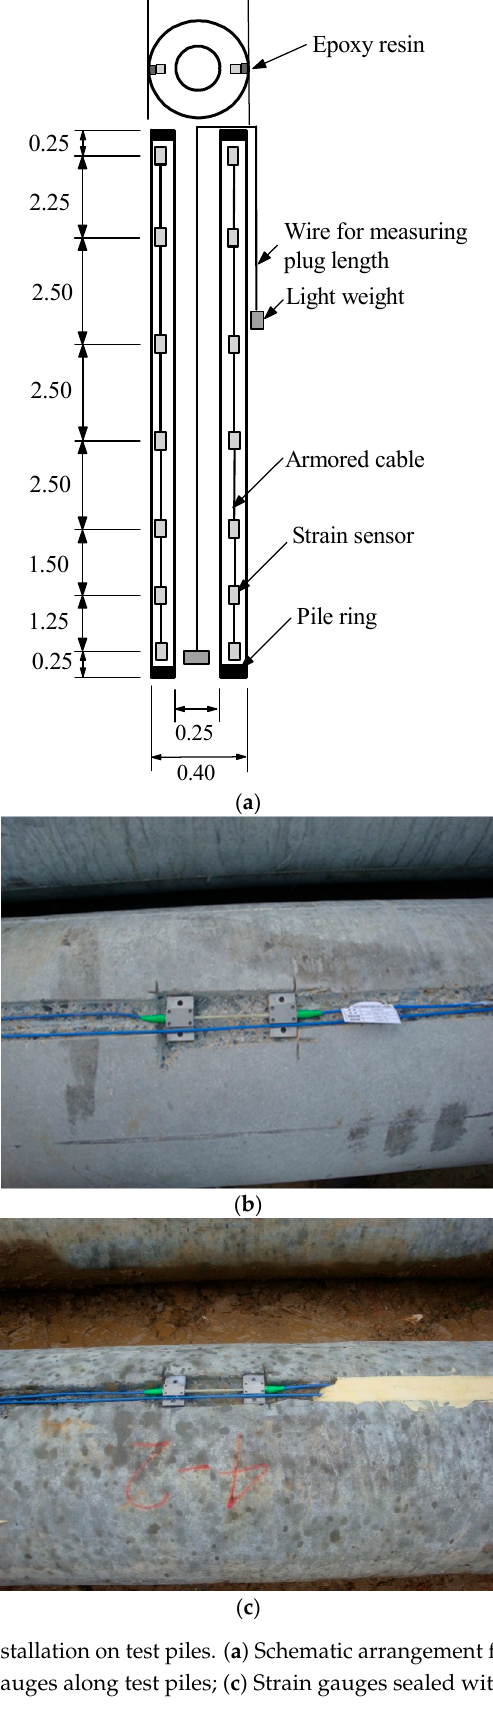
Figure 3. Strain gauges installation on test piles. ( a ) Schematic arrangement for strain gauges (Unit: m); ( b ) Installation of strain gauges along test piles; ( c ) Strain gauges sealed with epoxy resin in field.